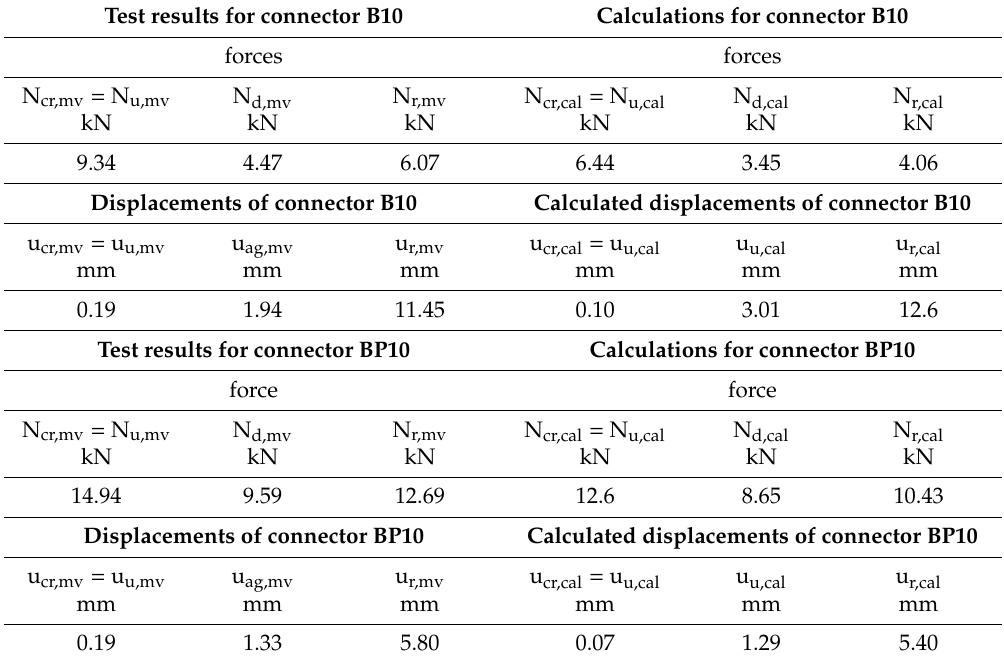
Table 14. Compared tests results and own calculations for the standard